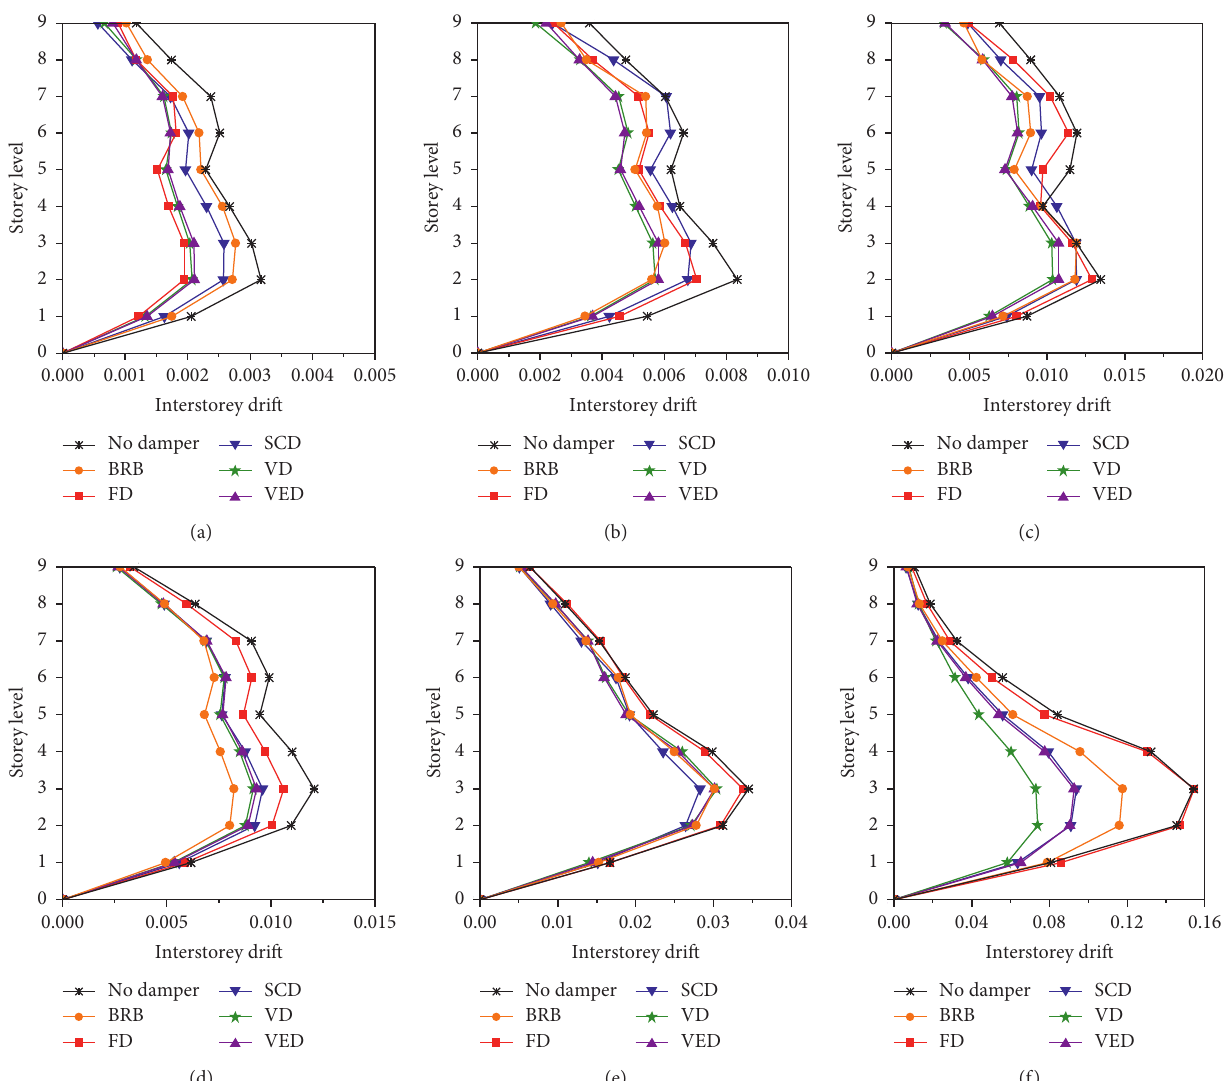
Figure 10: Maximum interstorey drift of building-damper systems under the frequent, occasional, and rare earthquakes of TCU039 and CHY010. (a) The FE of CHY010. (b) The OE of CHY010. (c) The RE of CHY010. (d) The FE of TCU039. (e) The OE of TCU039. (f) The RE of